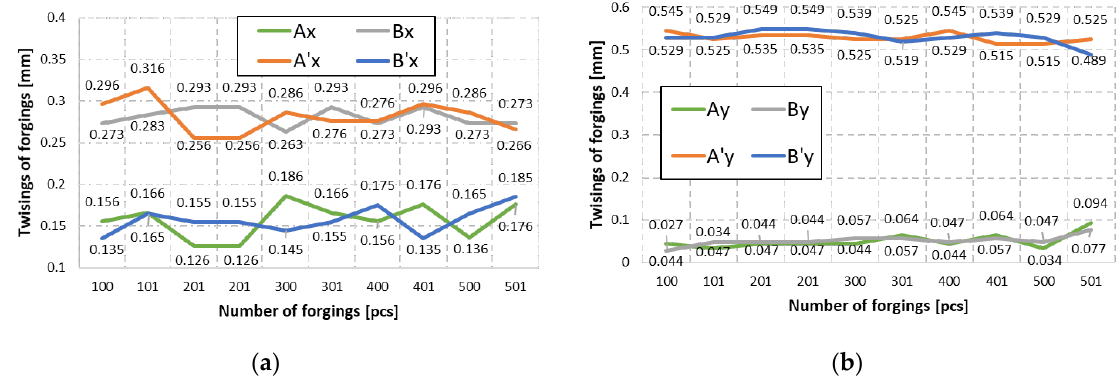
Figure 17. Diagram of the joggle values of two consecutive forgings cyclically collected every 100 items from the process, for the forging bay with geometrical defects: ( a ) components calculated in axis X, ( b ) components calculated in axis Y.